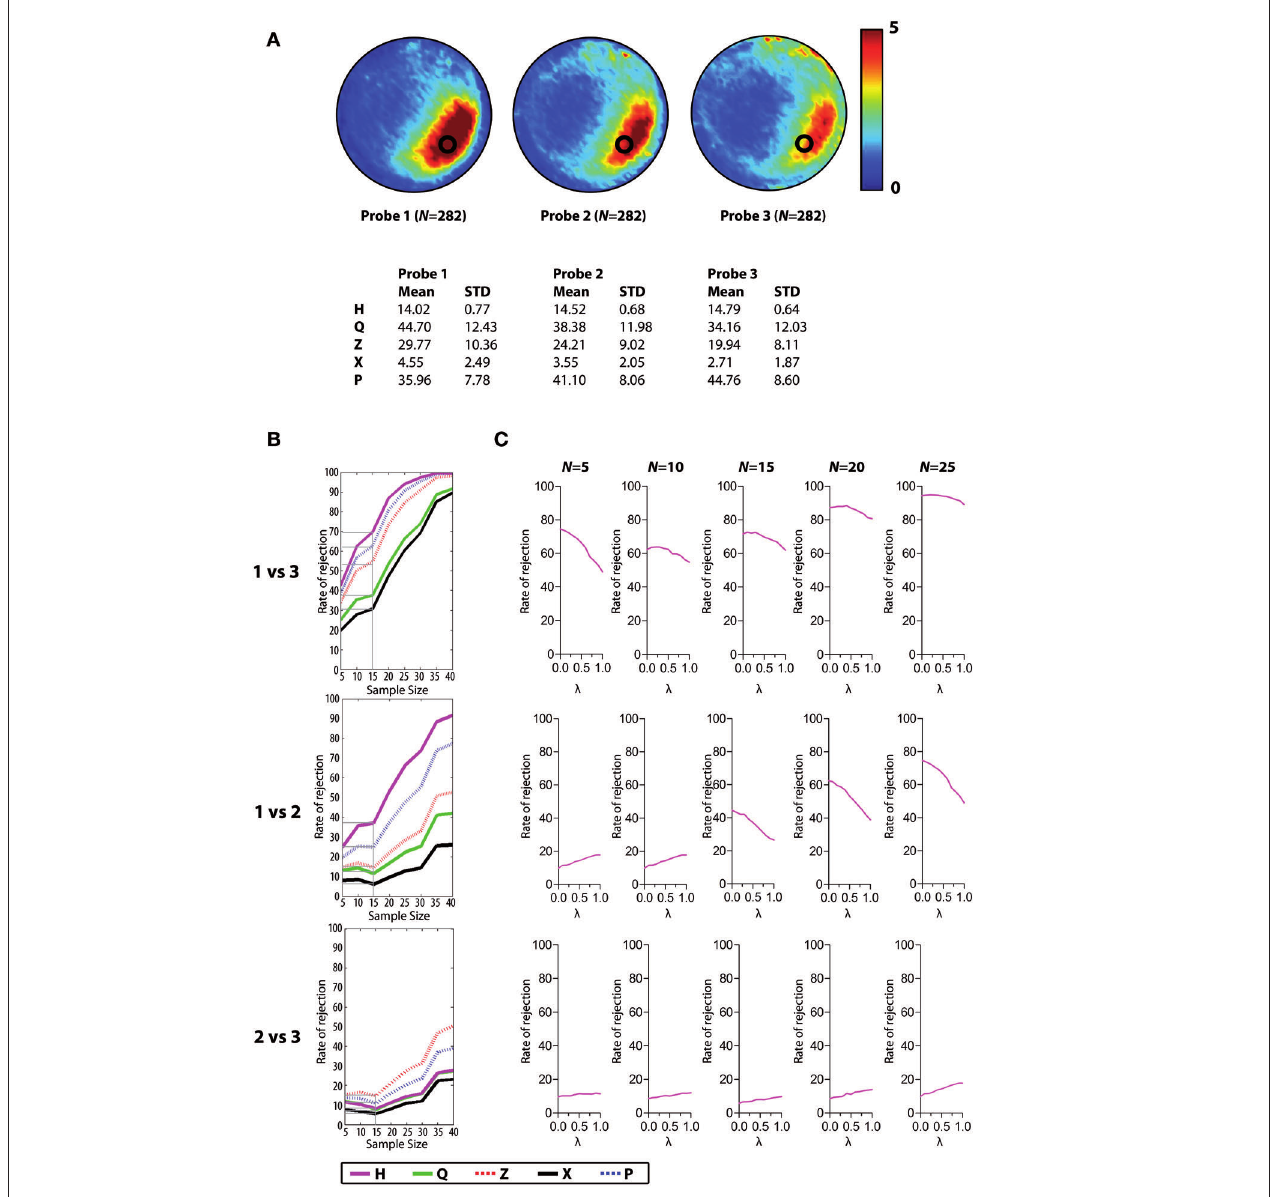
to all measures. (B) The likelihood of detecting a difference between the probes 1, 2 and 3 datasets is shown for varying sample ( N ) size, with signifi cance levels α = 0.05, 0.01 and 0.001 using the K–S test. (C) The performance of H at λ varying from 0 to 1.0 in steps of 0.1 with N -values ranging from 5 to